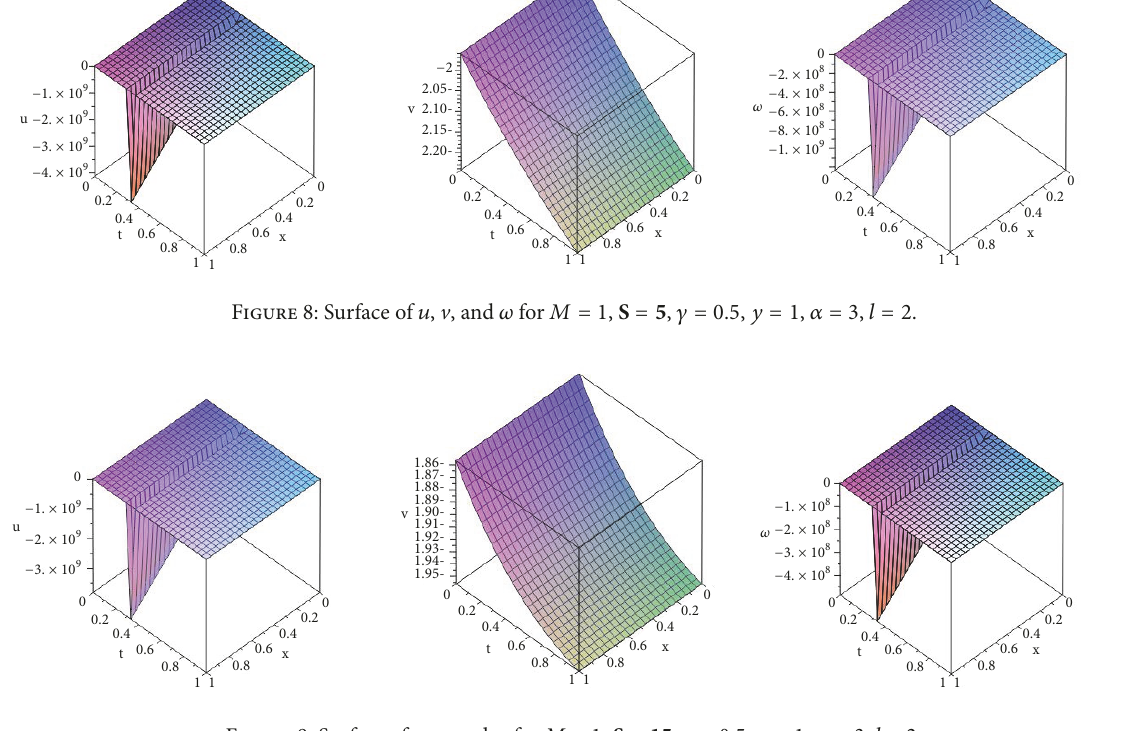
Figure 9: Surface of 𝑢 , V , and 𝜔 for 𝑀 = 1 , S = 15 , 𝛾 = 0.5 , 𝑦 = 1 , 𝛼 = 3 , 𝑙 = 2 .